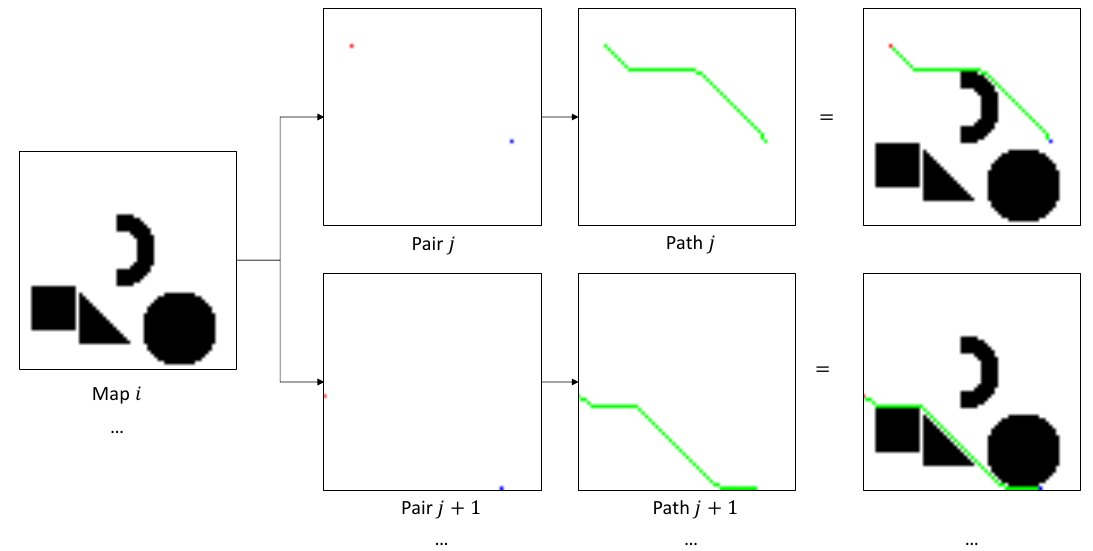
Figure 4. Dataset structure. Each map of procedurally generated obstacles was subjected to multiple goal pairs that were used to generate a path via